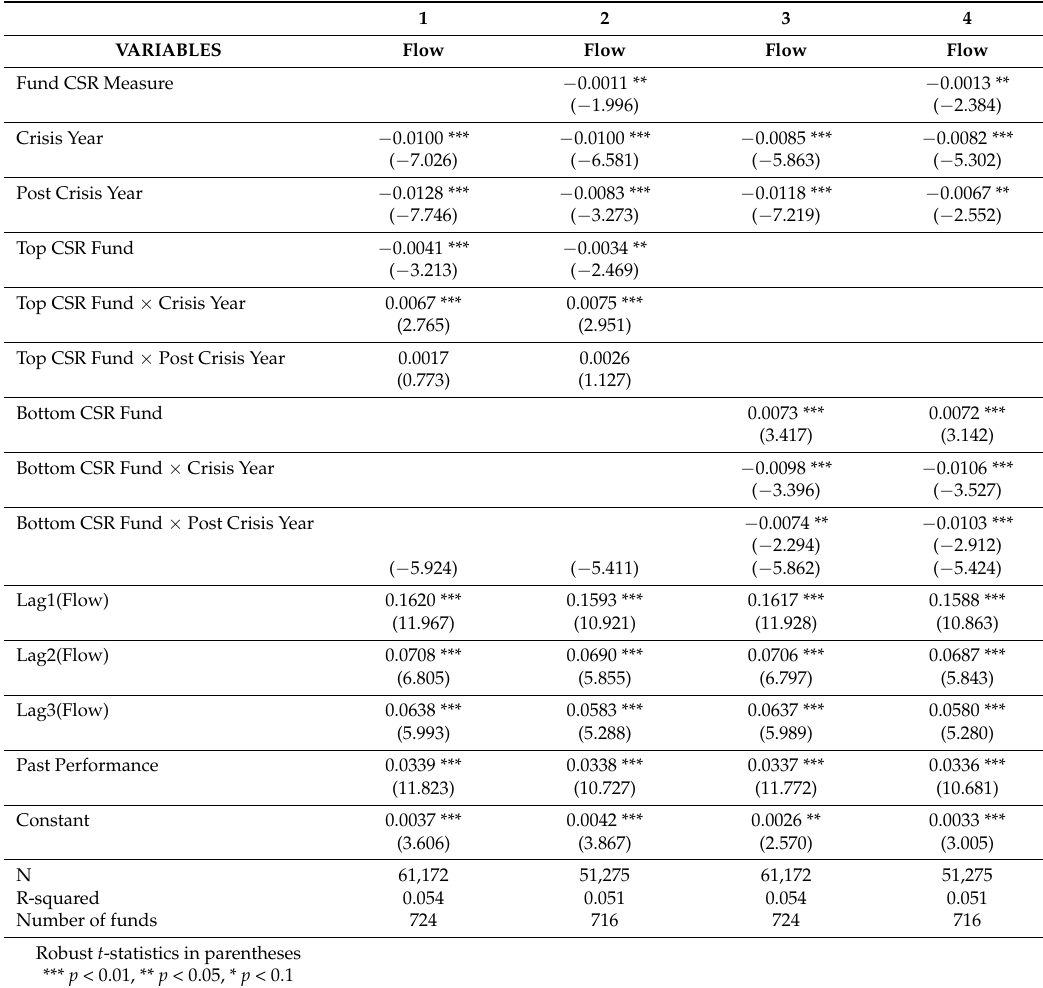
Table 7. CSR fund flows, financial crisis, and post-crisis period (Fixed effect model). 1 2 3 4 VARIABLES Flow Flow Flow